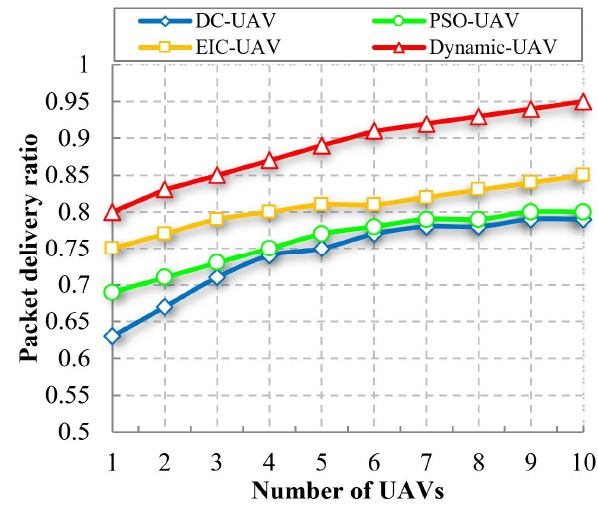
Figure 9. Number of UAVs vs. PDR.